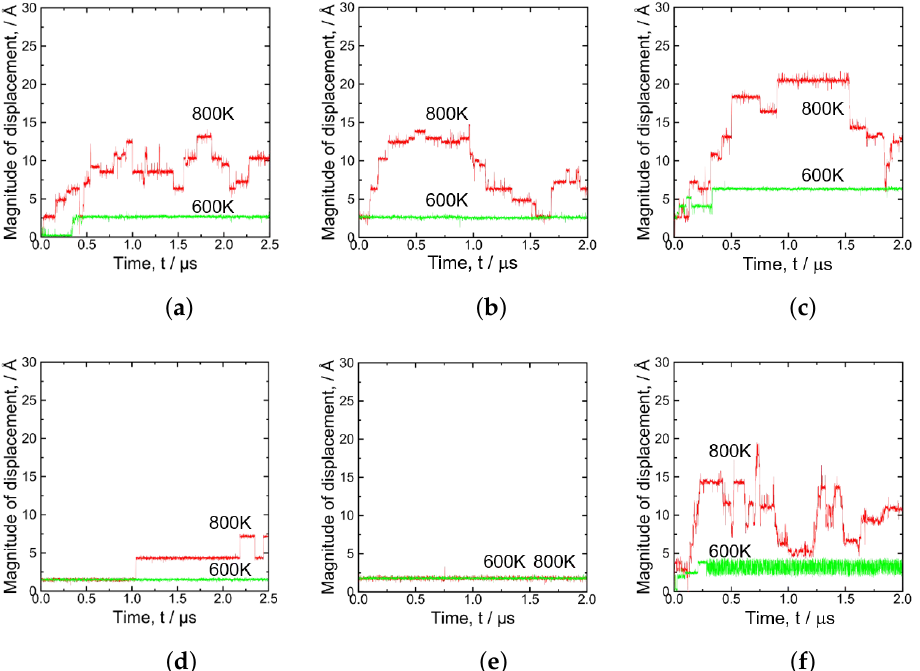
Figure 5. Magnitude of P atom displacement ( a – c ) for Σ 3 GB and ( d – f ) for Σ 5 at 600 K and 800 K: The left graphs ( a , d ) show the cases of placing a P atom at Site 0; the center ones ( b , e ) are for the cases of placing a P atom at Site 2; the right graphs ( c , f ) are for the cases of inserting a vacancy at the nearest neighbor site of the P atom at Site 2.